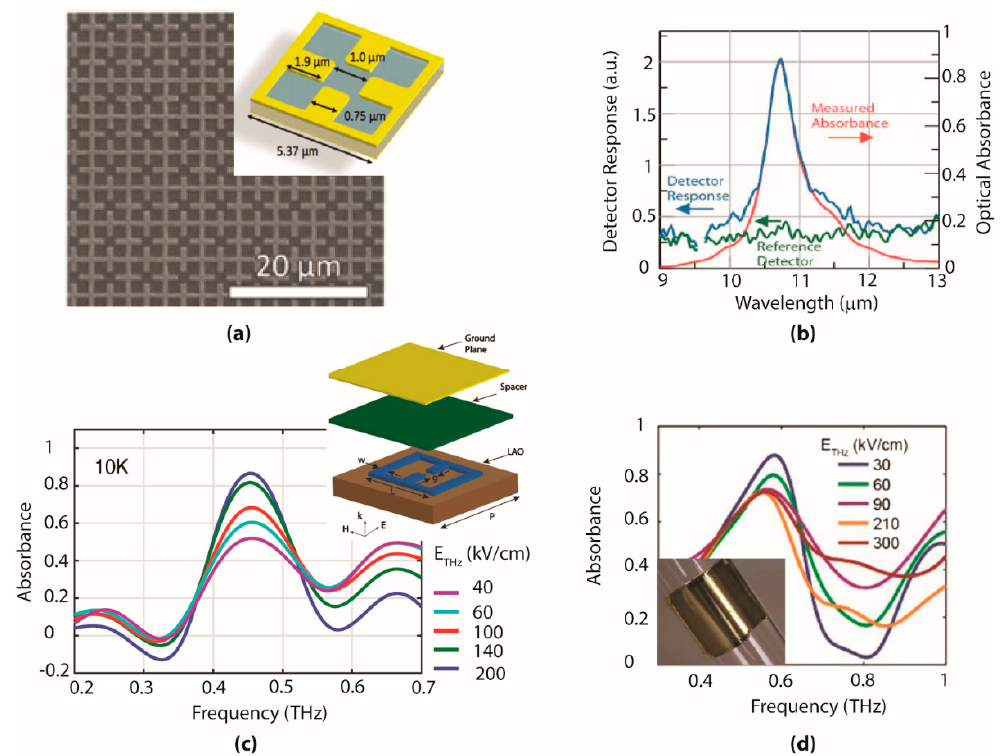
Figure 4. Applications of high fields and field confinement in MM detectors and saturable absorbers. ( a ) A metamaterial/pyroelectric based IR detector with enhanced sensitivity due to field confinement in the resonator gaps, where a pyroelectric material responds to the local field [61]. ( b ) Plot of the absorption and response curve for the MM from ( a ). ( c ) A THz saturable absorber designed using superconducting MMs (see inset for schematic). The resonant fields in the MM couple the nonlinear response of the YBCO superconducting SRR to produce an absorption peak that depends on the incident THz power, as shown here. Reproduced from [62]. ( d ) Another example of a THz saturable absorber. Here, small GaAs patches are placed in the confined fields of a metamaterial resonator